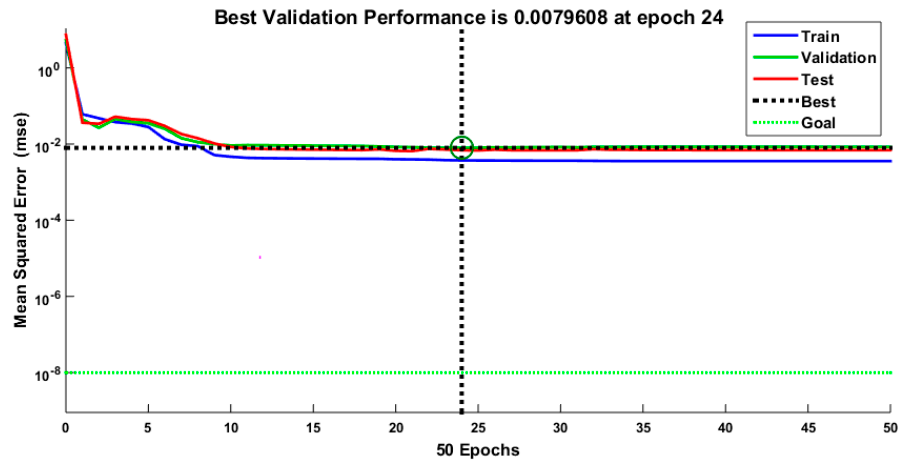
Figure 5. Training, validation, and testing MSE curves during RMS resampled normal signal mod- eling using AMRXU.